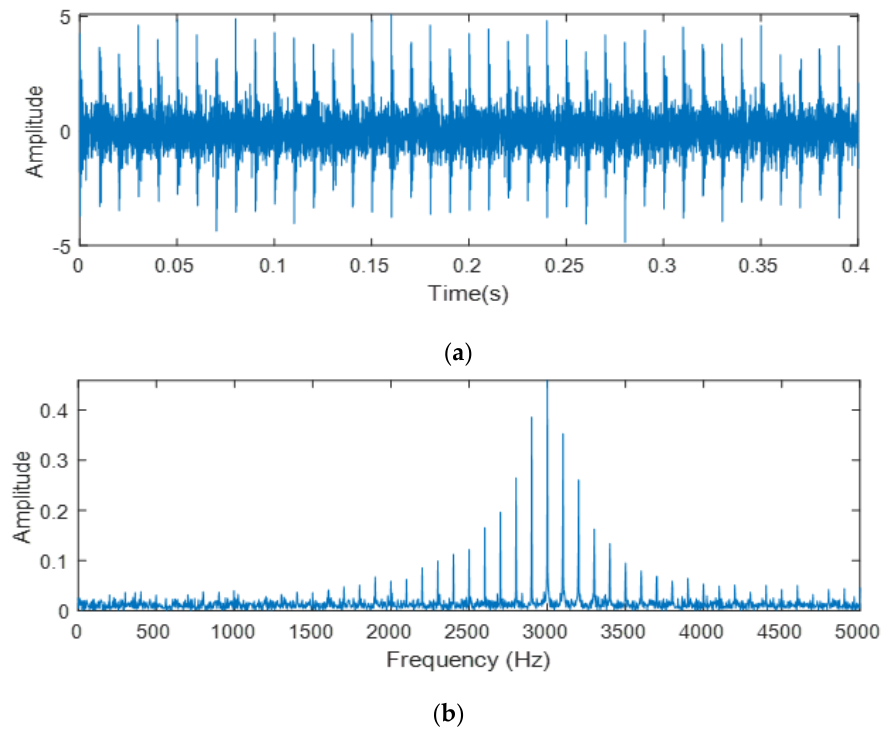
Figure 1. Simulated signal of a faulty bearing: ( a ) waveform; ( b ) spectrum.